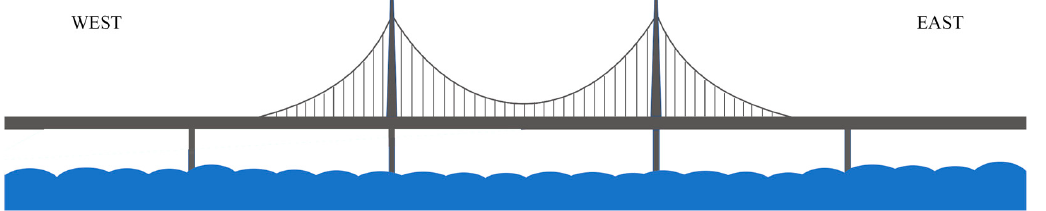
Figure 7. Sketch of the Sanchaji Bridge.